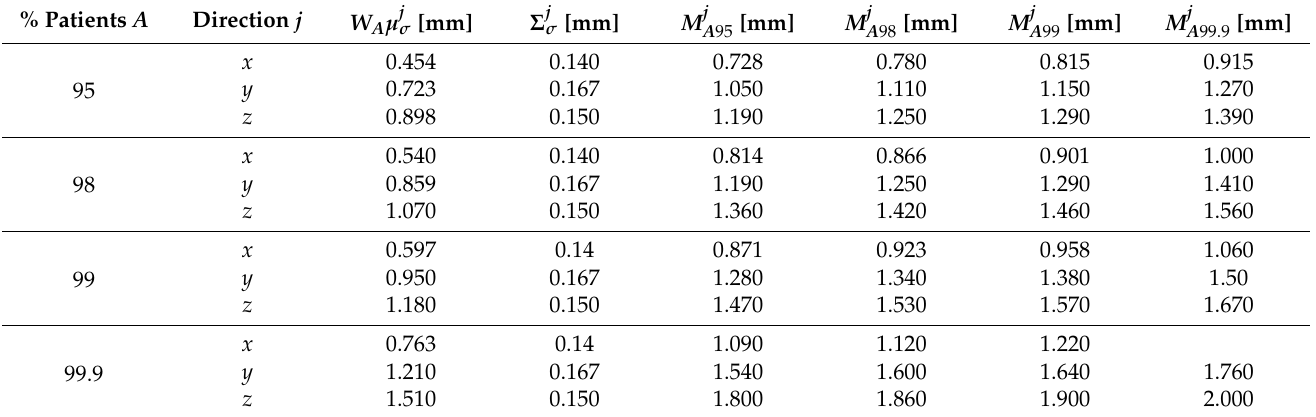
Table 3. Safety margins using the time length intervals I = 50 s.